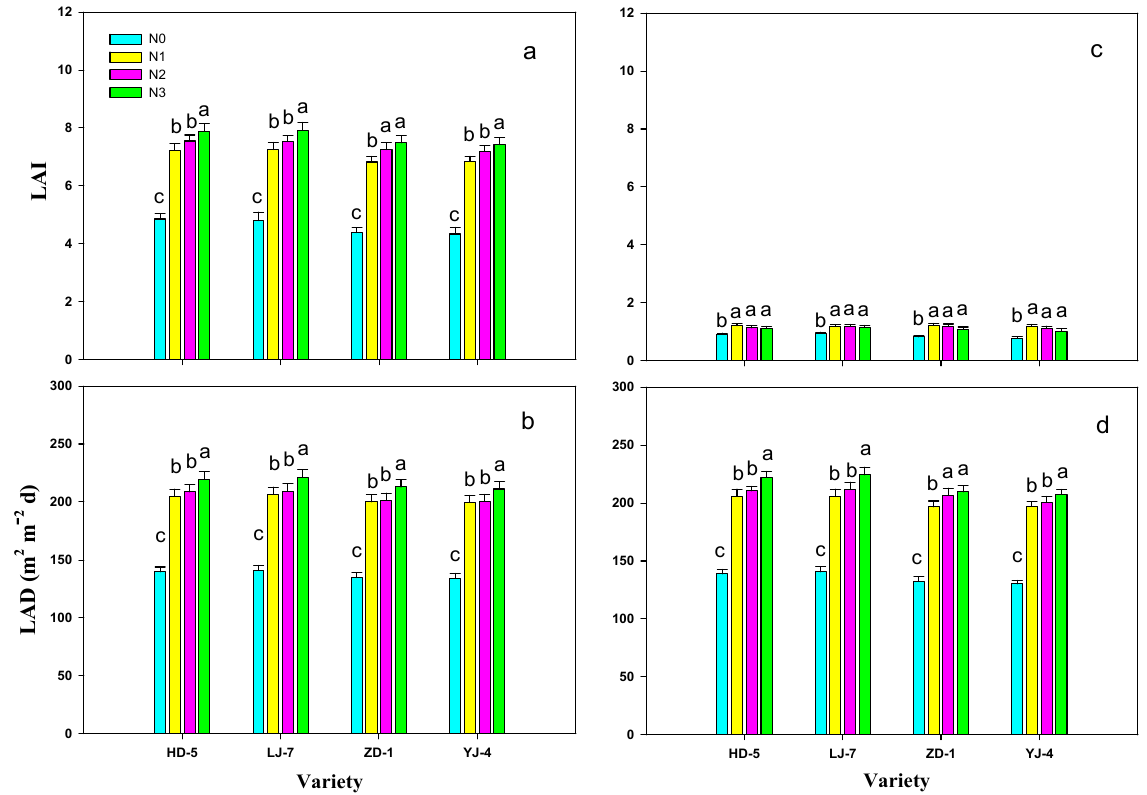
Figure 4. Leaf area index (LAI) of rice at heading time ( a ) and maturity ( c ), and Leaf area duration (LAD) from panicle initiation to heading ( b ) and from heading to maturity ( d ) under various N management strategies: the vertical bars represent the ± standard error of the mean, where these exceed the size of the symbol. No shared letter above the column indicates statistical significance at the p = 0.05 level within the same variety. N0, zero-N control; N1, panicle N applied at spikelet differentiation (SD); N2, panicle N split at PI and SD; and N3, panicle N applied at panicle initiation (PI). HD-5, Huaidao 5; LJ-7, Lianjing 7; ZD-1, Zhongdao 1; and YJ-4, Yangjing 4038. Table 6. Nitrogen (N) uptake and NUE of rice under various N managements. Variety 1 Treatment 2